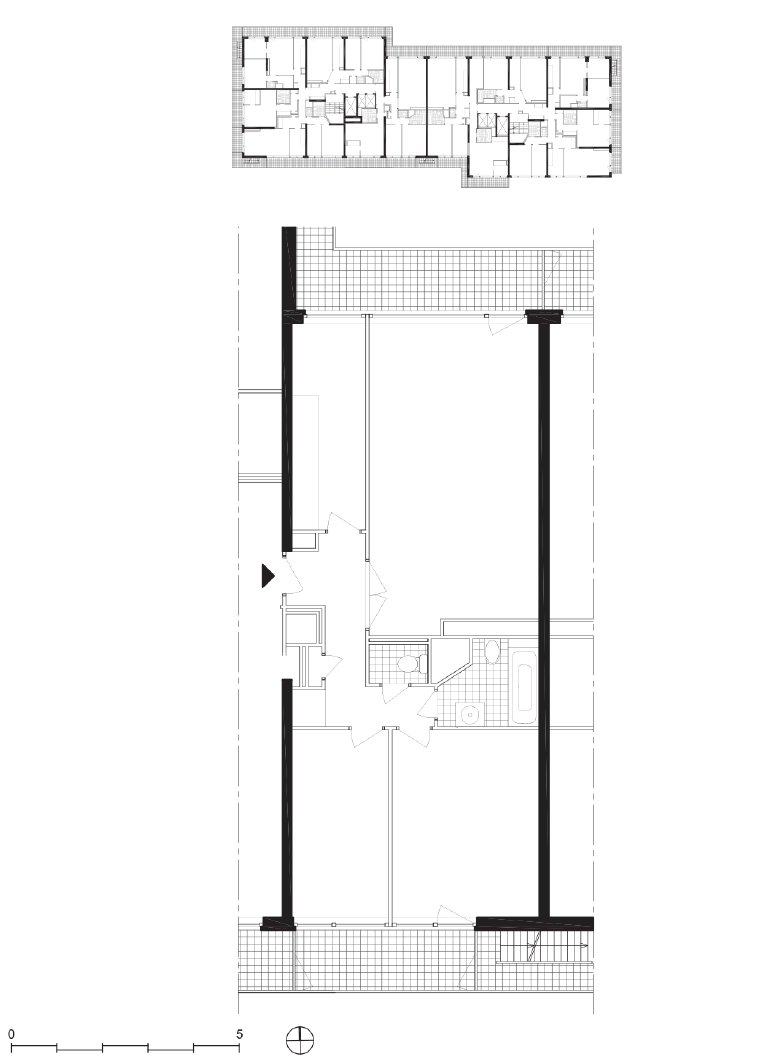
Figure 8. Amelinckx, Héliport , 1971 (drawings by the author). all the multilevel innovations developed in pre-war lay- outs are replaced by mainly single-storey